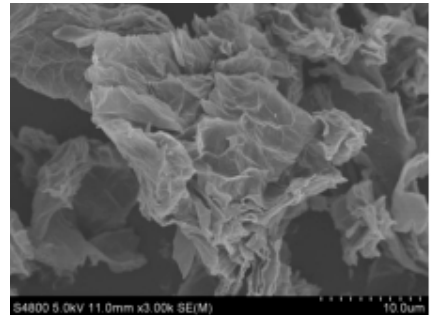
Table 1. The physical parameters of graphene.